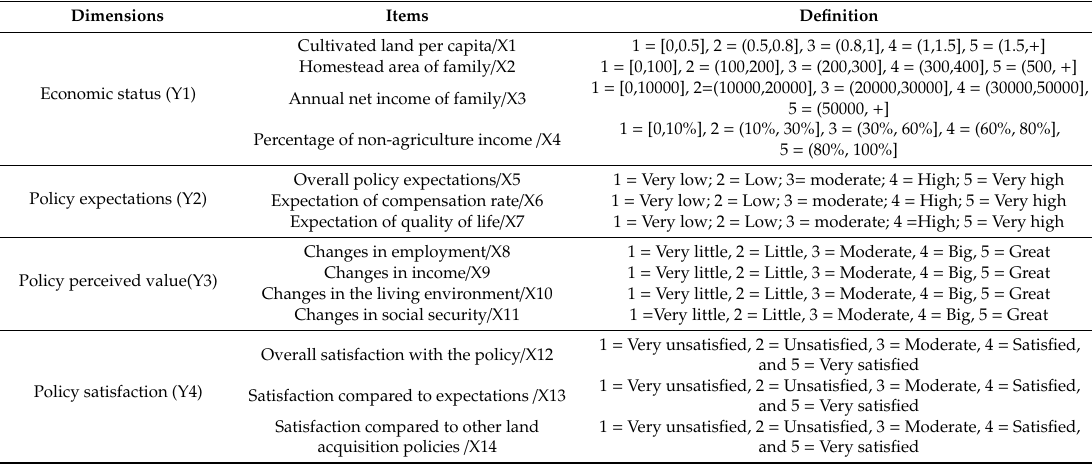
Table 1. Variables used to analyze factors a ff ecting farmers’ satisfaction with homestead withdrawal policy.